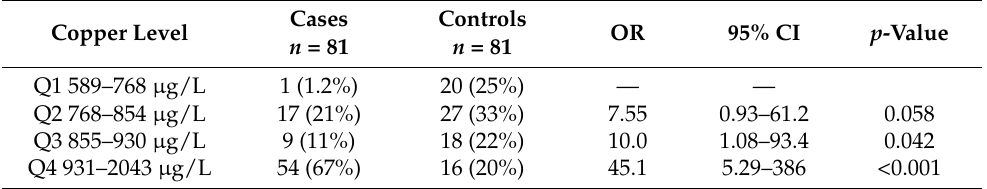
Table 12. Blood copper levels and the occurrence of cancer localized in the colon.